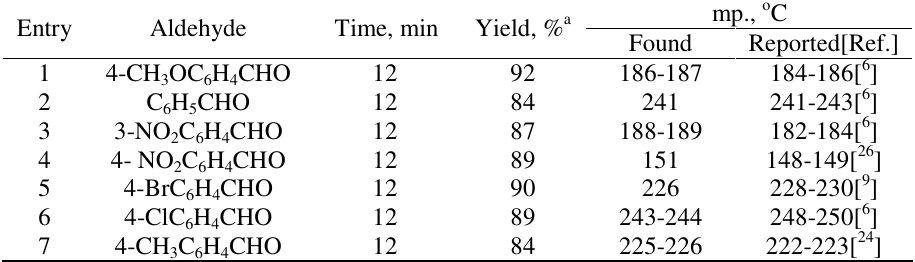
Table 2. Synthesis of 1-amidoalkyl-2-naphthols using catalytic amount of H (2 mol% ) under solvent-free conditions at 130 o C Entry Aldehyde Time, min Yield, % a